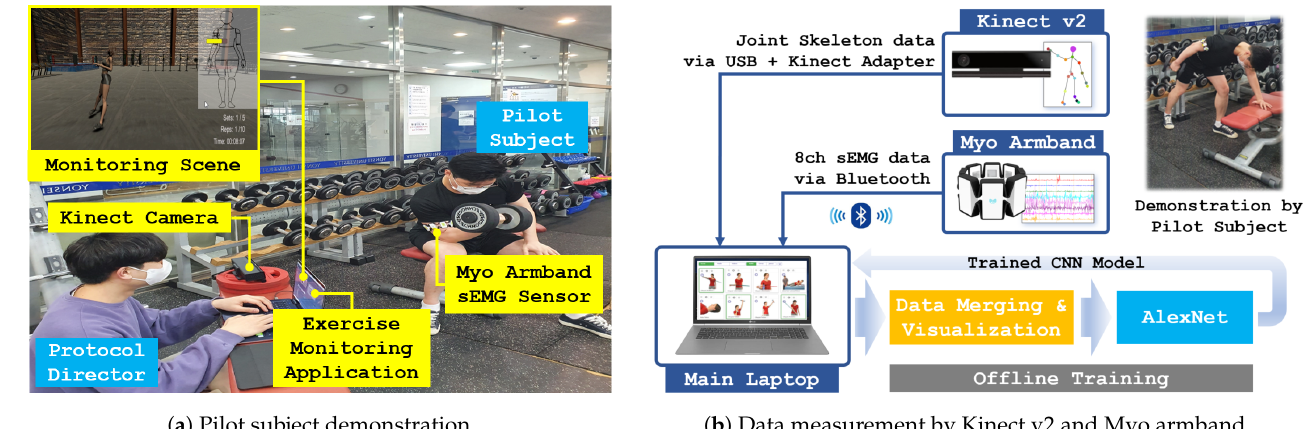
Figure 1. The overall system architecture: the measured data from Kinect v2 and Myo armband are merged and visualized. The visualized image is used as an input for CNN training. Both a pilot subject and a protocol director are wearing a mask by following the government quarantine instruction against COVID-19.